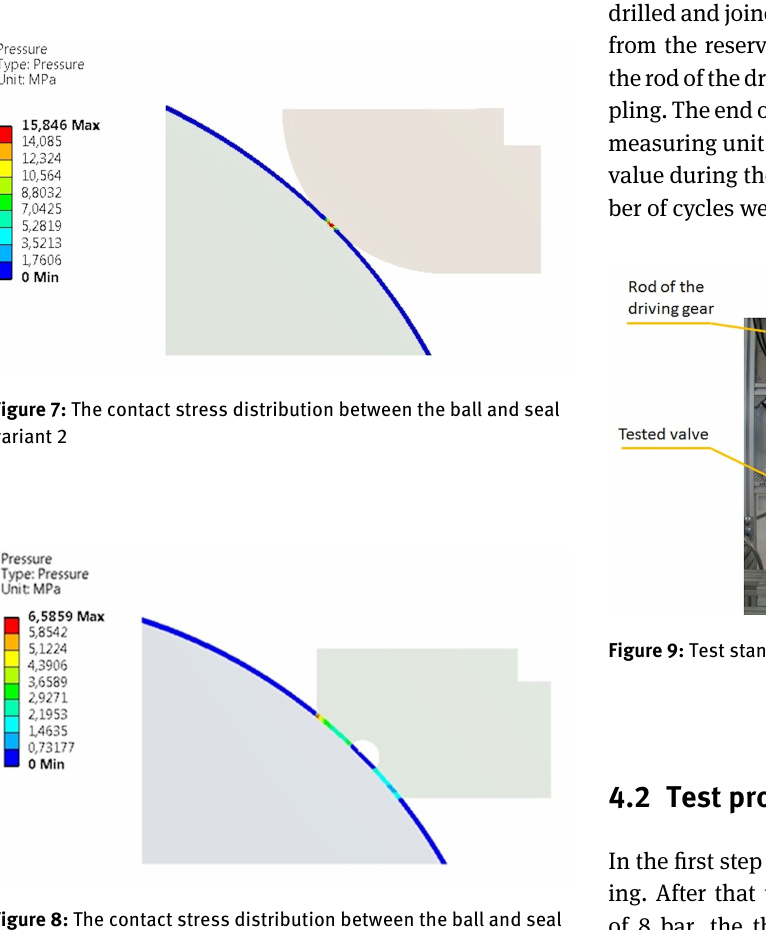
Figure 8: The contact stress distribution between the ball and seal variant